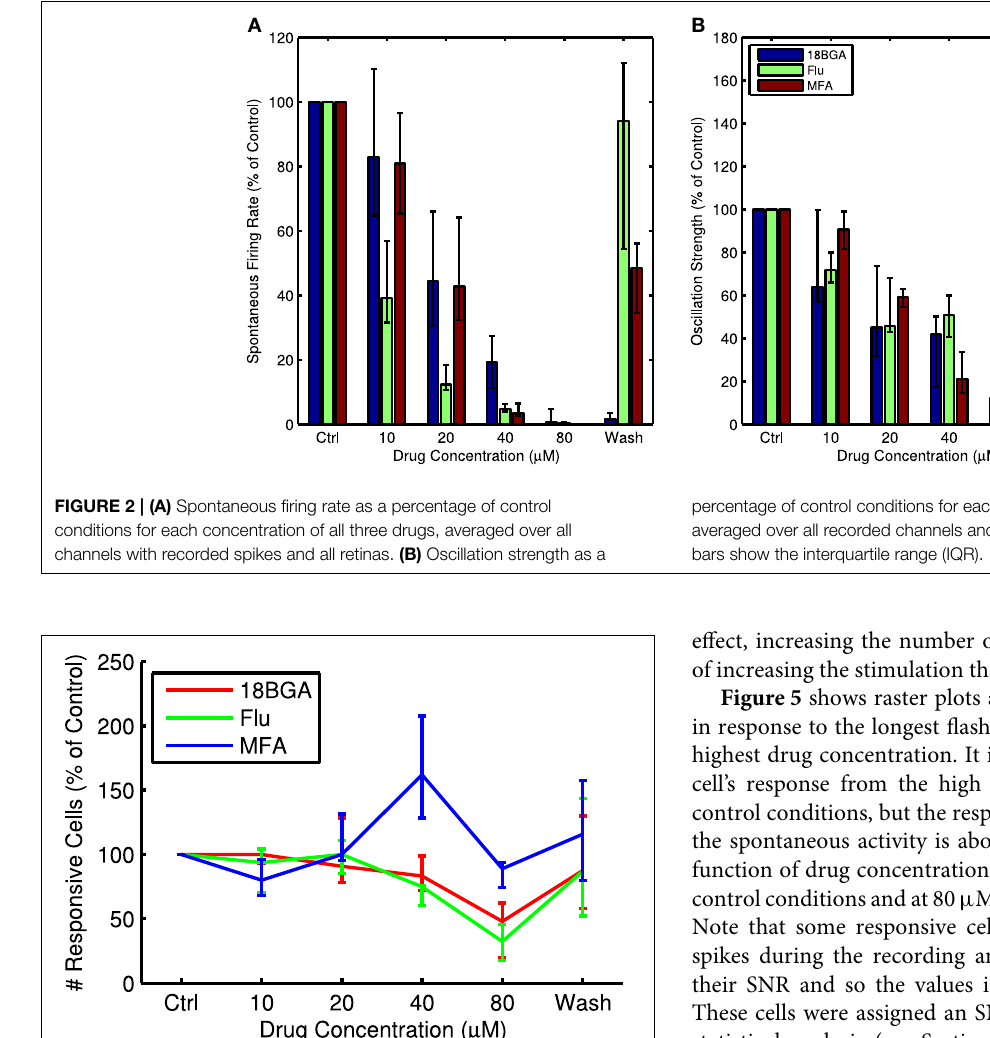
FIGURE 3 | Number of cells responding to the longest µ LED array flash at each drug concentration as a percentage of control conditions, averaged over all